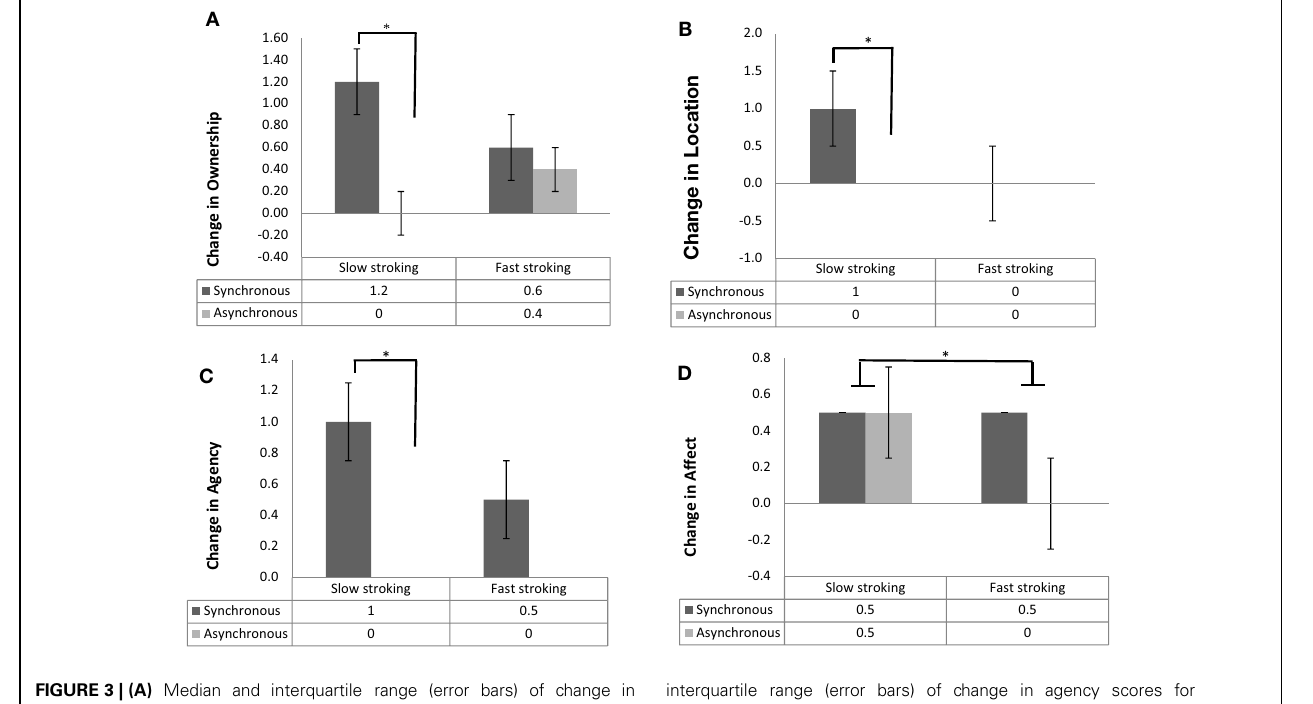
FIGURE 3 | (A) Median and interquartile range (error bars) of change in ownership scores for synchrnous (dark gray bars) and asynchronous (light gray bars) stroking. (B) Median and interquartile range (error bars) of change in location scores for synchronous (dark gray bars) and asynchronous (light gray bars) stroking. (C) Median and